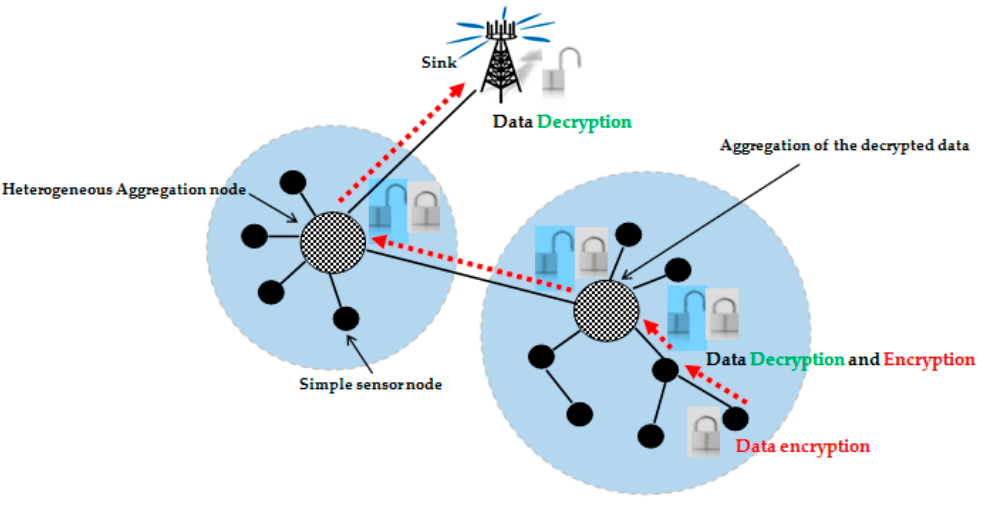
Figure 4. Hop by hop data aggregation security approach.